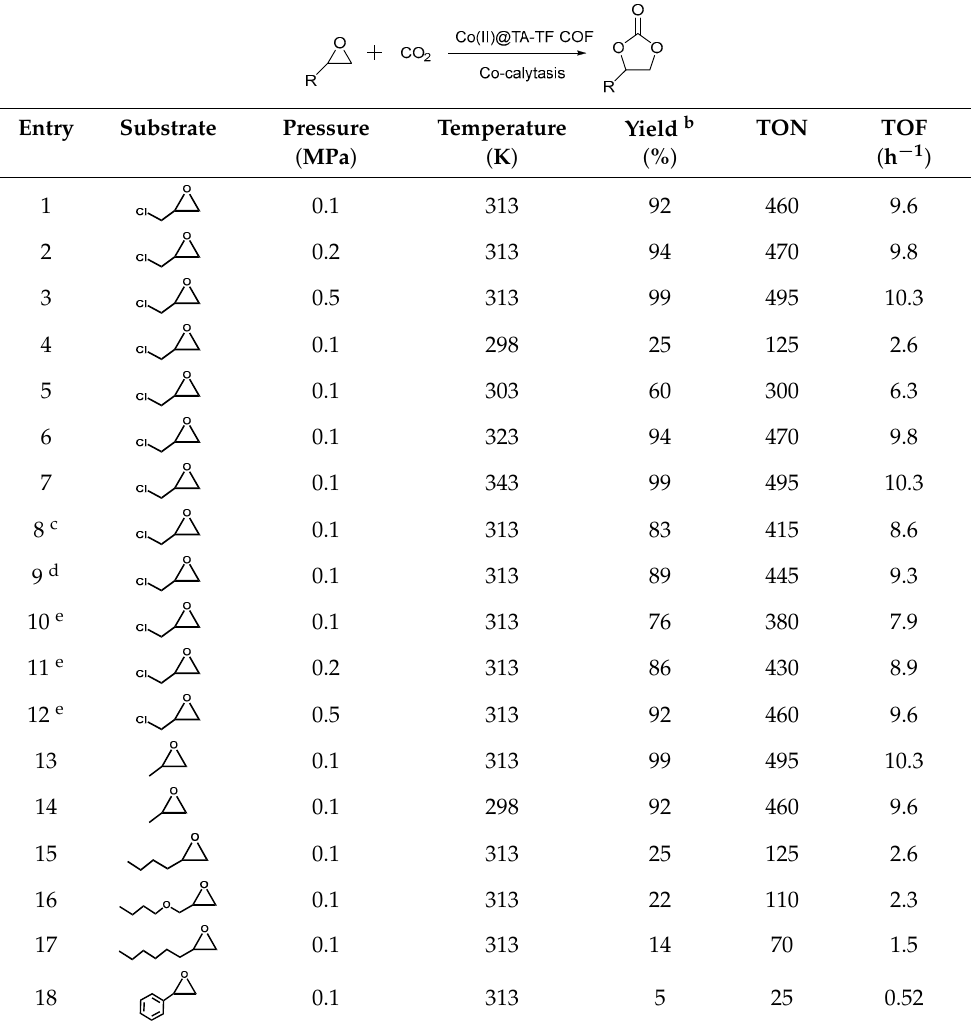
Table 1. Influence of various experimental conditions on cycloaddition reaction. a